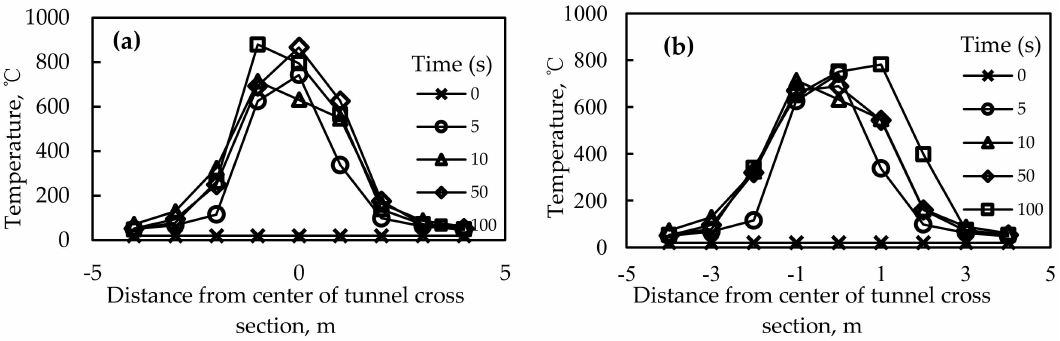
Figure 6. Distribution of temperature along the transverse direction; ( a ) without fire retardant; ( b ) with fire retardant.